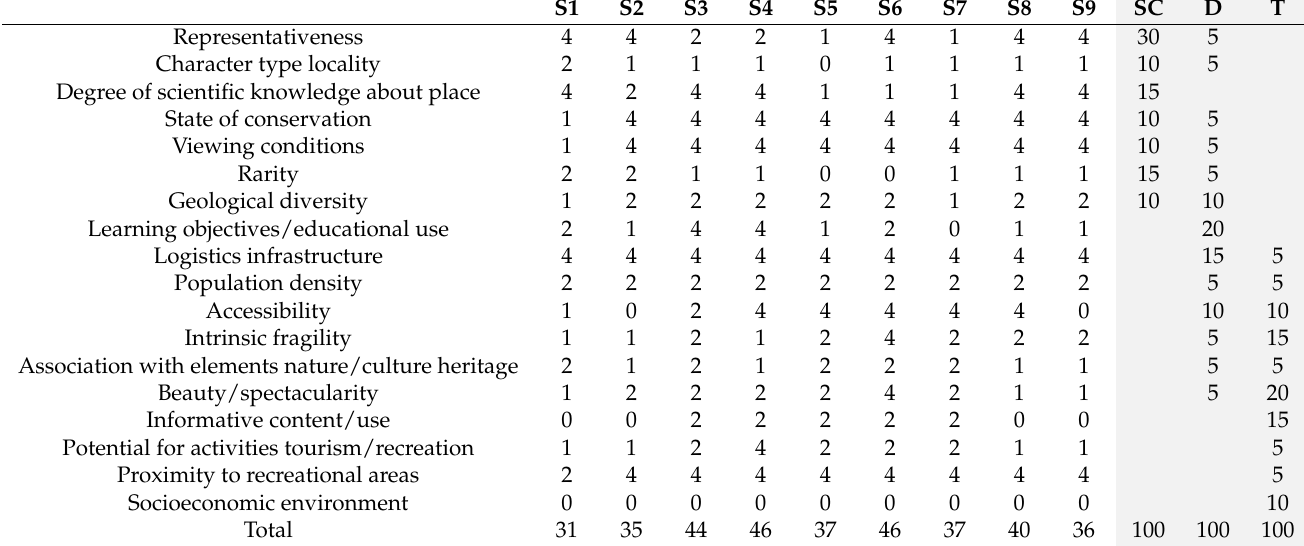
Table 1. Assessment of the parameters for the geosites.